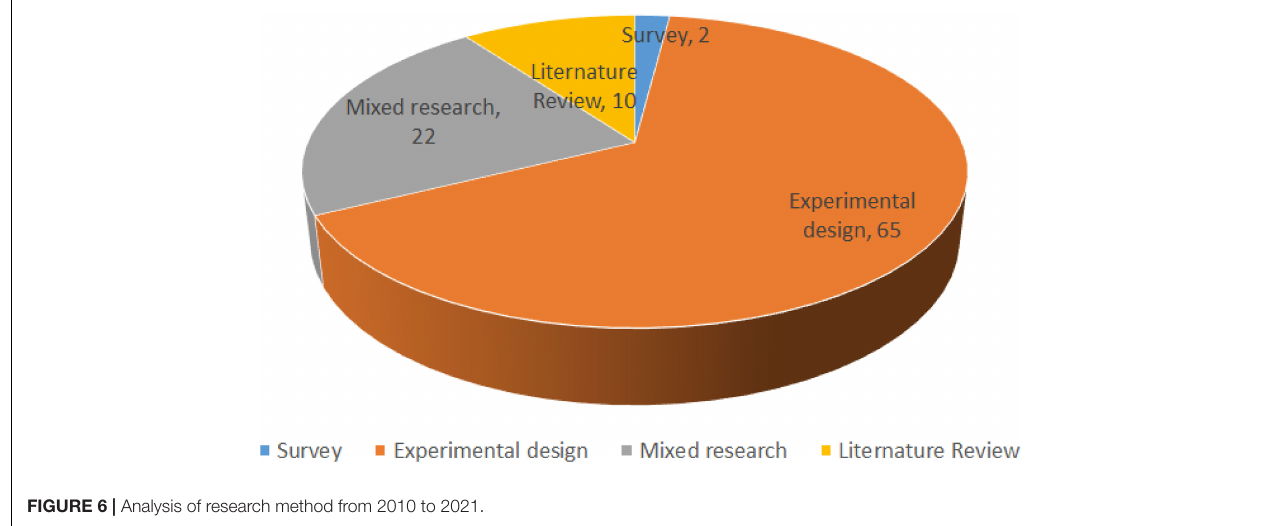
FIGURE 6 | Analysis of research method from 2010 to 2021.